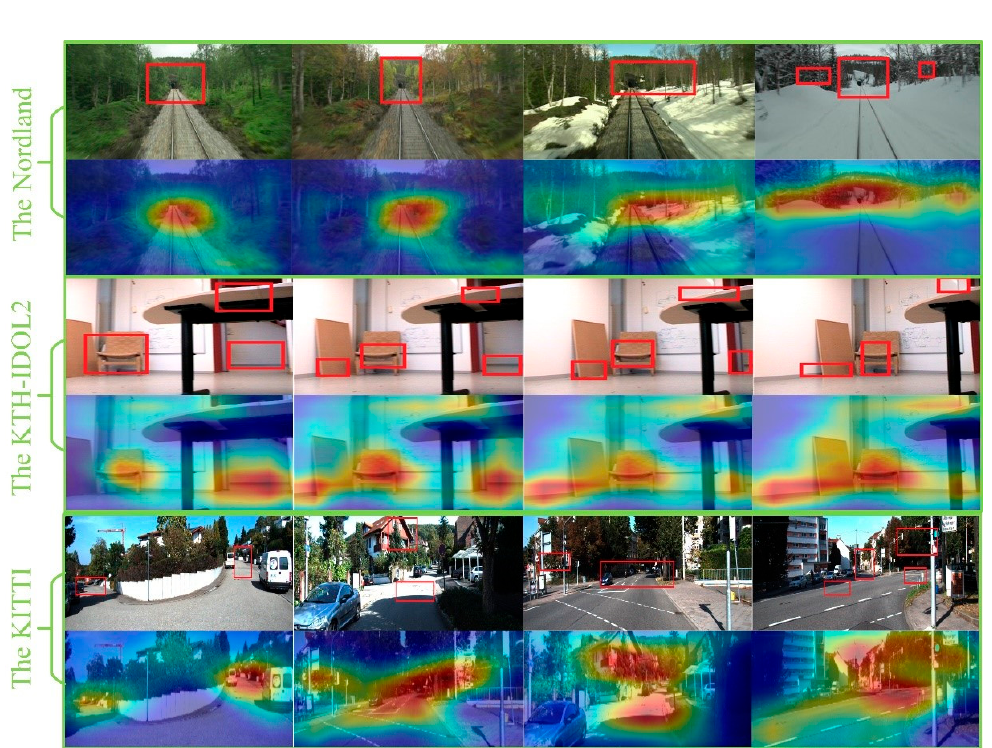
Figure 6. Recognized salient regions with our proposed method. Image samples come from three different datasets. The red rectangular represents salient region and highlighted regions represent salient regions recognized.